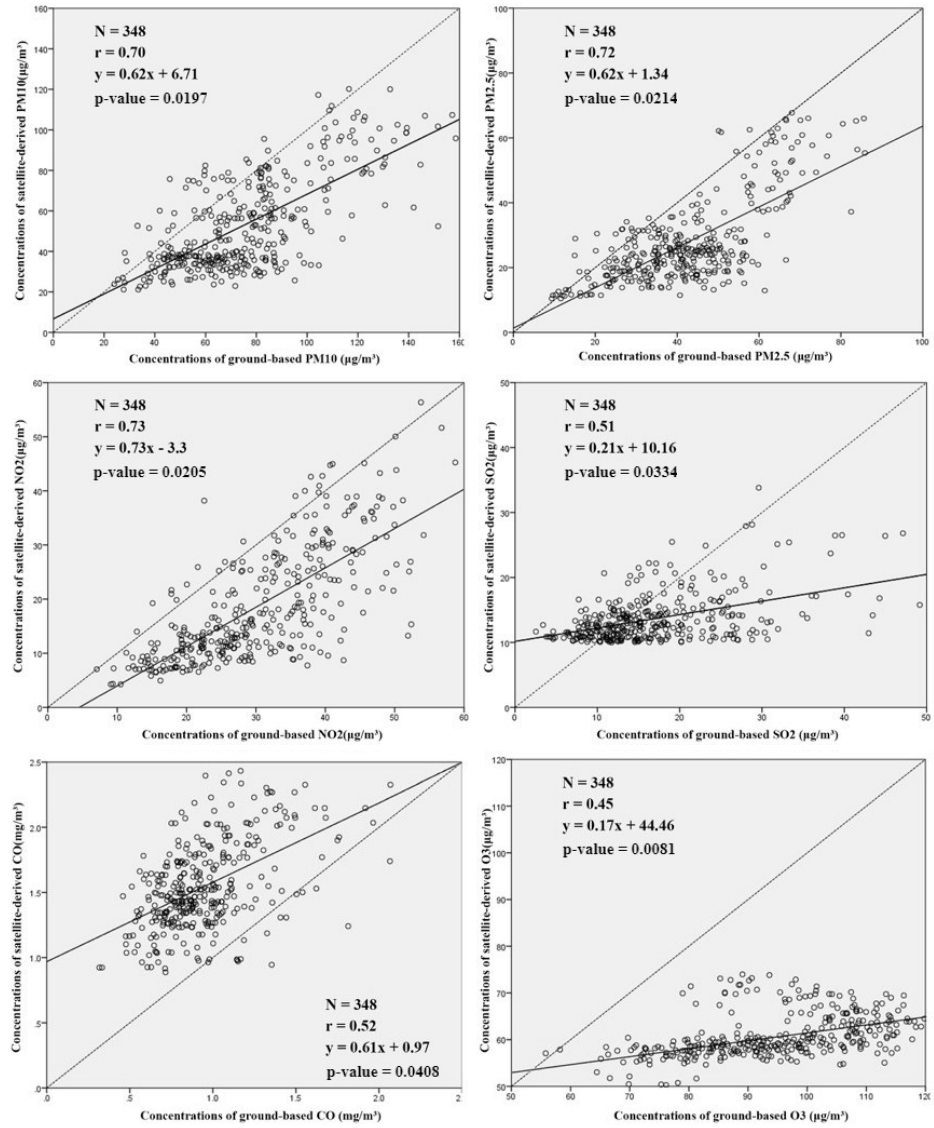
Figure 8. The correlation between satellite-retrieved and ground-based pollutants concentrations.